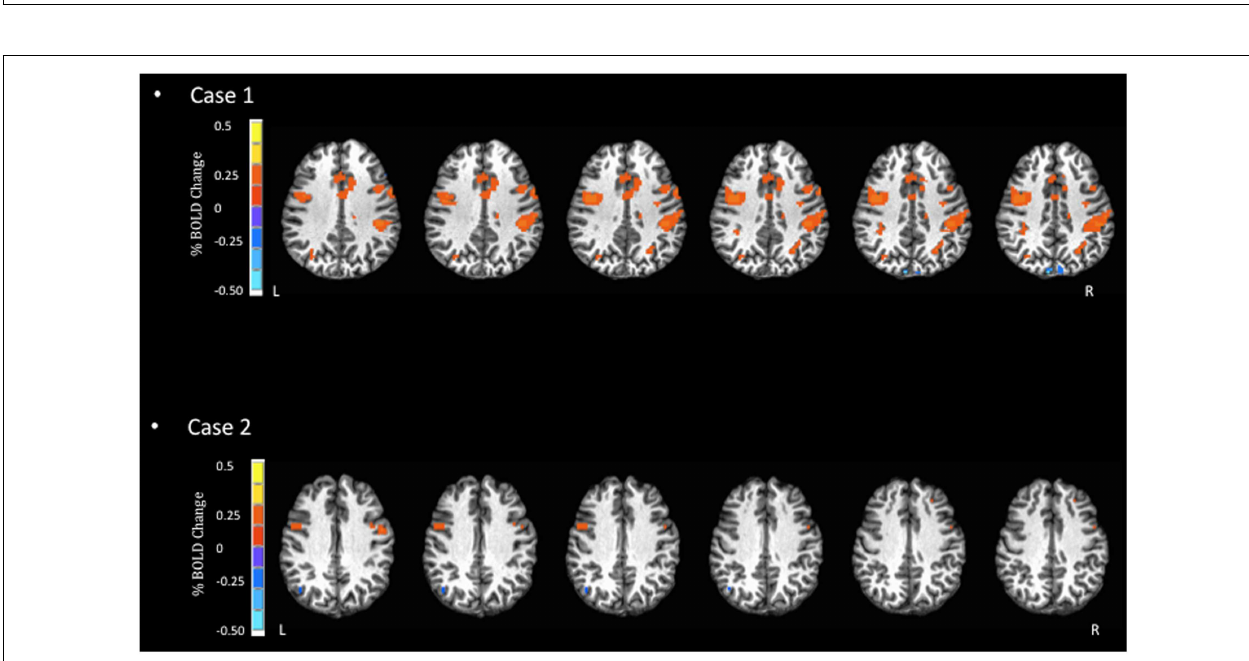
FIGURE 2 | Blood oxygen level dependent signal activation for spatial processing task . In this task, Case 1 displays more dispersed and increased BOLD activation in the inferior frontal and pre-central gyri, as well as the insula. In contrast, Case 2 displays little BOLD activation.